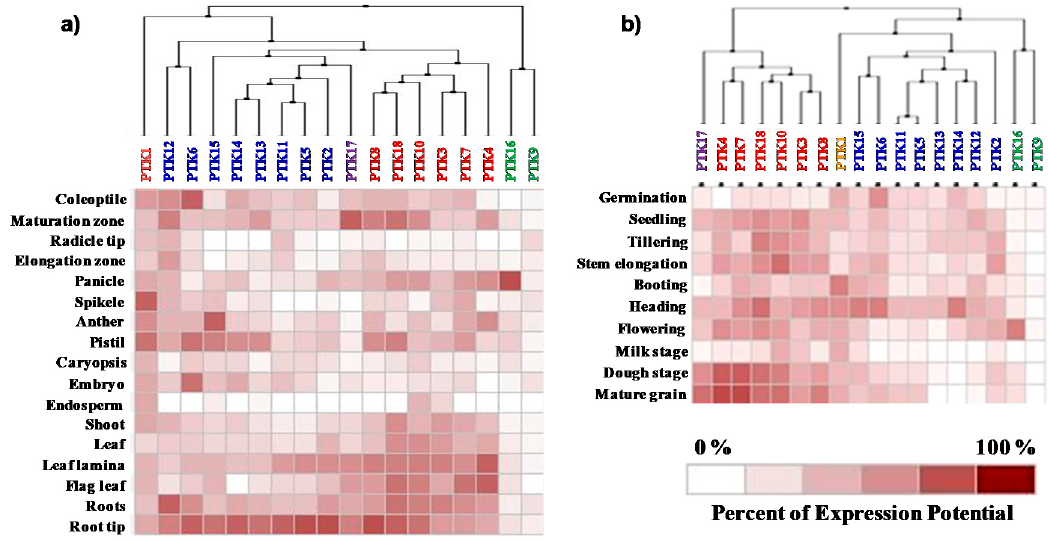
Figure 5. Expression analysis of PTK genes of rice. ( a ) Di ff erent tissues; ( b ) developmental stages. Expression analysis was carried out with mRNAseq datasets using Genevestigator. Genes in same cluster are given same color to facilitate easy comparison between a) tissues and b) developmental stages.